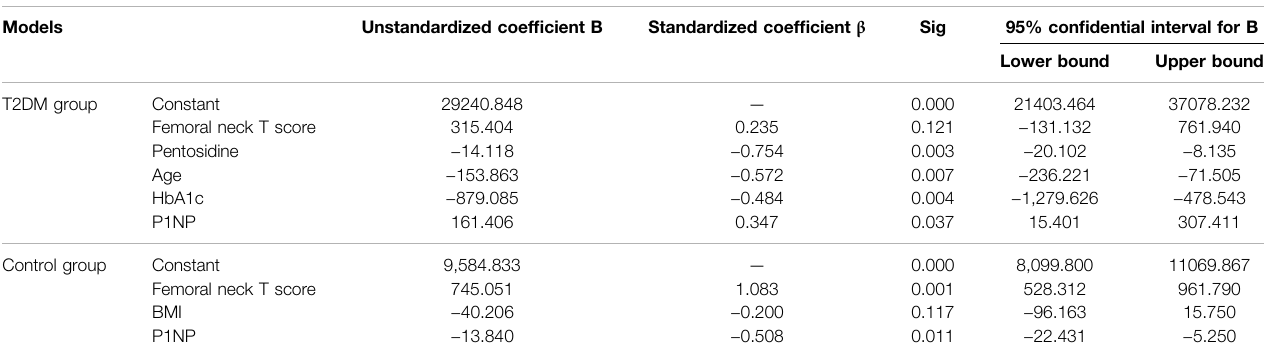
TABLE 4 | The best models for predicting femoral strength of T2DM and control groups.